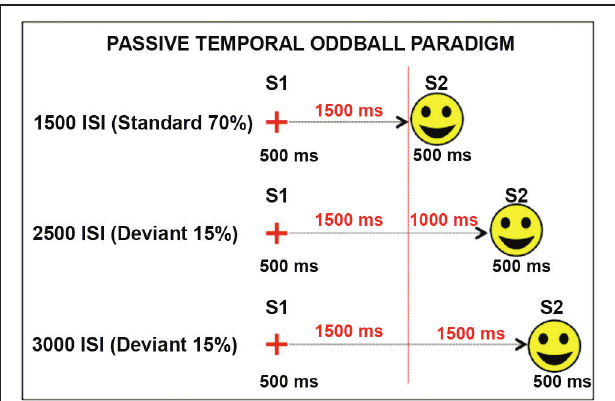
FIGURE 1 | Passive temporal oddball task. S1 and S2 never changed across conditions. The only manipulated variable was the ISI delay. In 70% of trials, the ISI was 1500 ms (1500 standard condition). In the remaining 30% of trials, the ISI was lengthened to 2500 or 3000 ms (2500 and 3000 deviant conditions, 15% each). Standard and deviant conditions were randomly presented. Participants were given neither instruction nor a motor task. The vertical dotted red line represents the S2 maximum expectation time point corresponding to the end of the standard